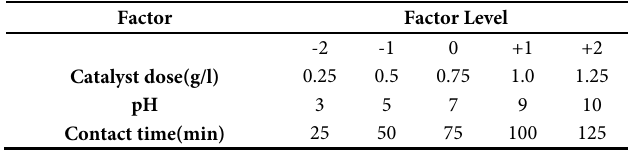
Table 3. The range and levels of the factors.